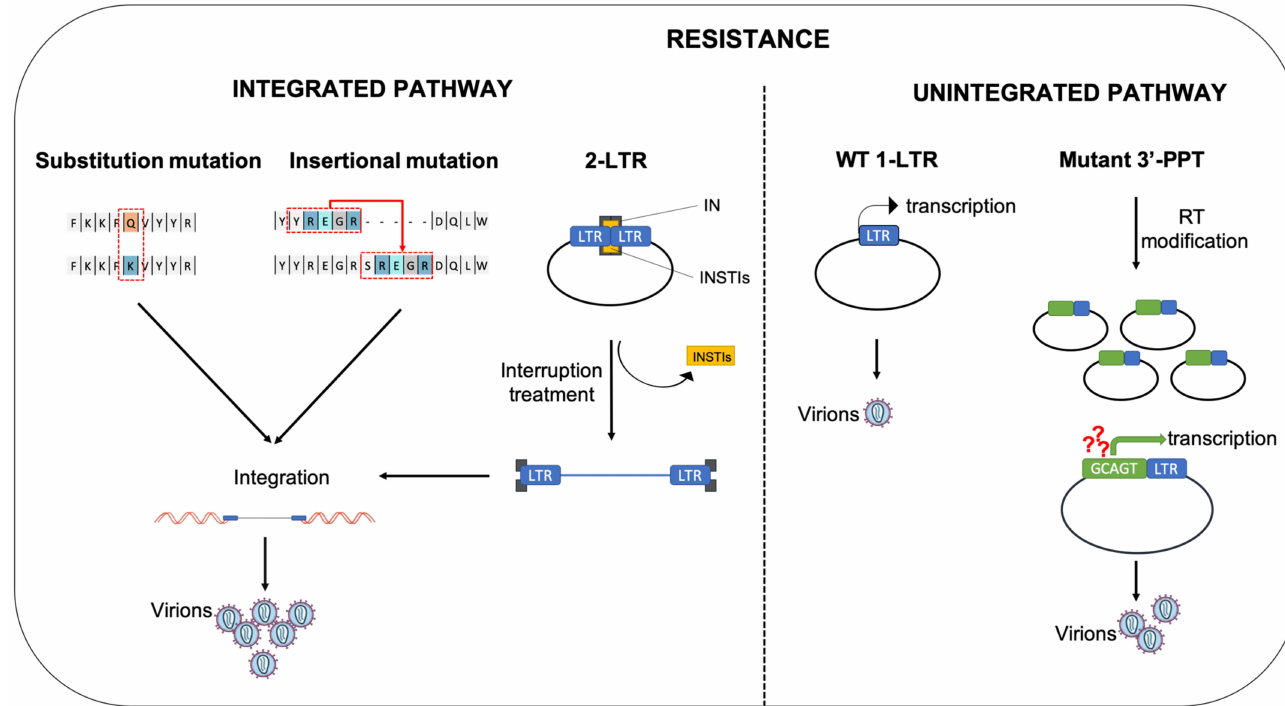
Figure 5. Different pathways of INSTI resistance. Two main pathways involving the integration step or unintegrated viral DNA can be responsible for INSTI resistance. Substitution mutations (replacement of one amino-acid by another one) or insertional mutations (insertion of one or several amino-acids) in the integrase protein can lead to INSTI resistance. In these pathways, integration of the viral DNA can occur because the mutated integrase is resistant to INSTIs but still active to mediate integration. Integrated DNA then allows the production of new viruses bearing these resistance mutations. Blocking of integration by INSTI treatment leads to accumulation of unintegrated DNA, in particular, 2-LTR circles. In case of interruption of treatment, integration from 2-LTR circles can occur due to the specific cleavage of the LTR-LTR junction before integration after release of the INSTI compound from the IN/DNA complex. Thus, 2-LTRc accumulated in cells treated with an INSTI may constitute a reserve supply of HIV-1 genomes that could be integrated de novo and revive viral replication. Unintegrated viral DNA could also contribute to INSTI resistance by a basal production of viruses from 1-LTR circles. Furthermore, mutations in the 3 (cid:48) -PPT region modify the reverse transcription step. In this case, reverse transcription does not result in linear DNA but in a 1-LTR circle. One hypothesis is that the 3 (cid:48) -PPT mutation leads to a higher transcription efficiency leading a higher viral production compared to the production from a 1-LTR circle that does not highlight the 3 (cid:48) -PPT mutation. Viruses with 3 (cid:48) -PPT mutations are resistant to INSTIs since their replication is independent of the integration pathway. Yellow square: INSTI. Black arrow: basal transcription from 1-LTR circles coming from a WT infection. Green arrow: hypothesis of higher transcription due to the 3 (cid:48) -PPT